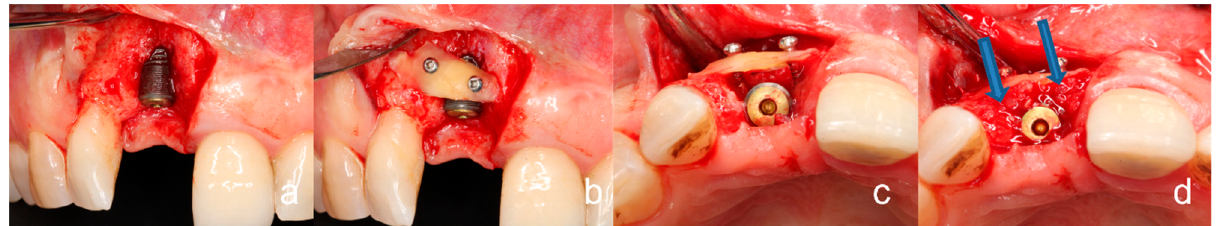
Figure 2. Successive illustration of the Tooth Shell Technique of a tooth that has been stored frozen: ( a ) Lateral view: Implant in region 11. The defect is visible. ( b , c ) Multilateral view (lateral and occlusal): The detin shell is stabilized with two osteosynthesis screws on the implant. ( d ) Particulated dentin in the interspace (blue arrows).